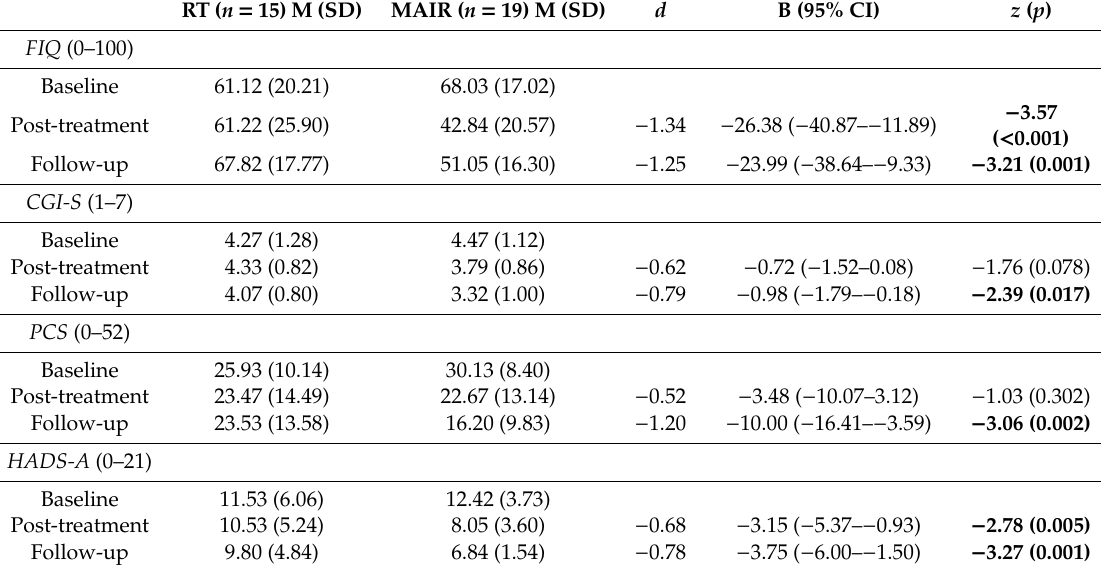
Table 3. Descriptives and analysis of the primary and secondary clinical